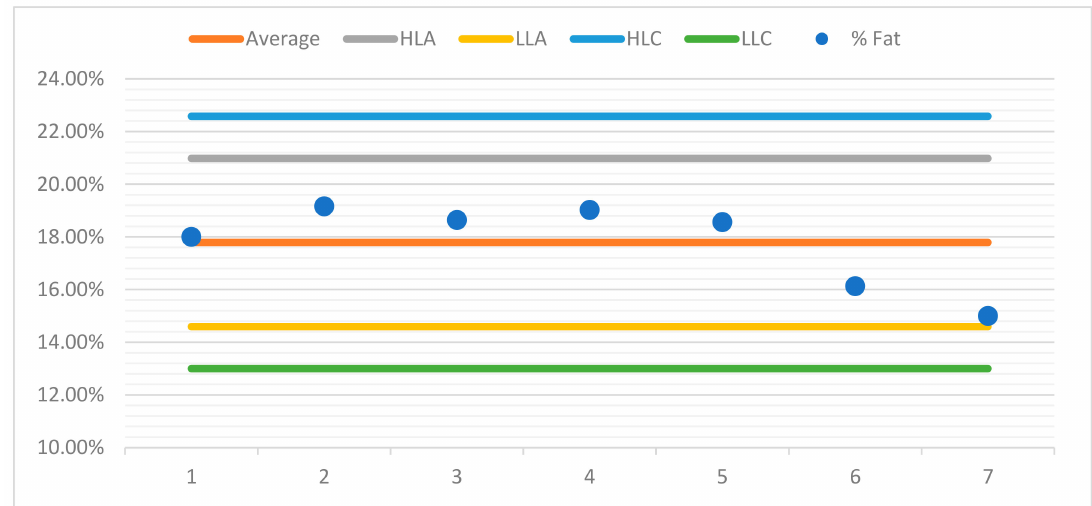
Figure 8. Control chart for